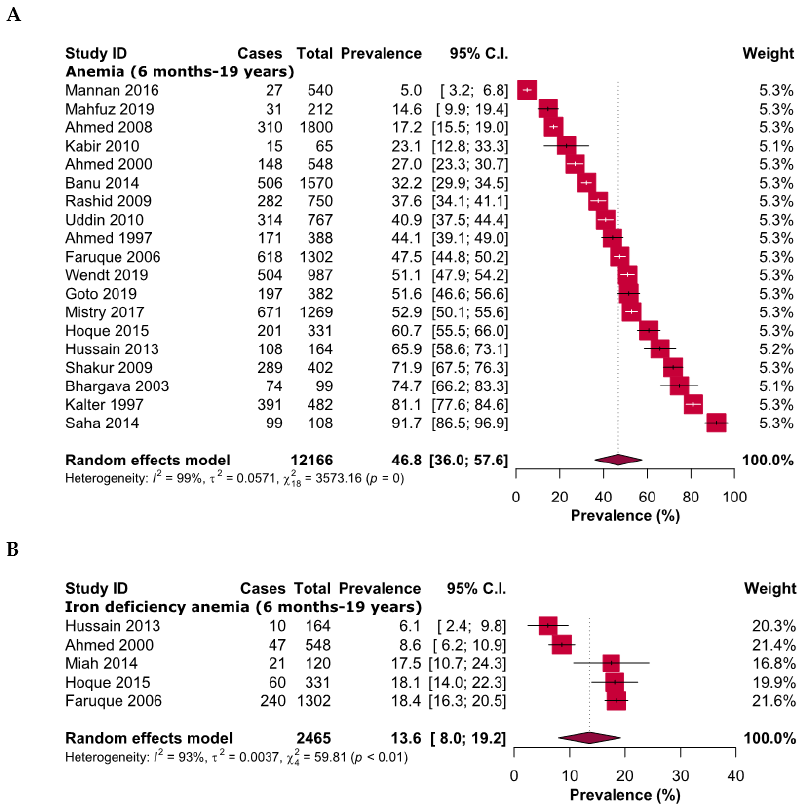
Figure 2. Prevalence of ( A ) anemia and ( B ) iron deficiency anemia in children and adolescents of Bangladesh.